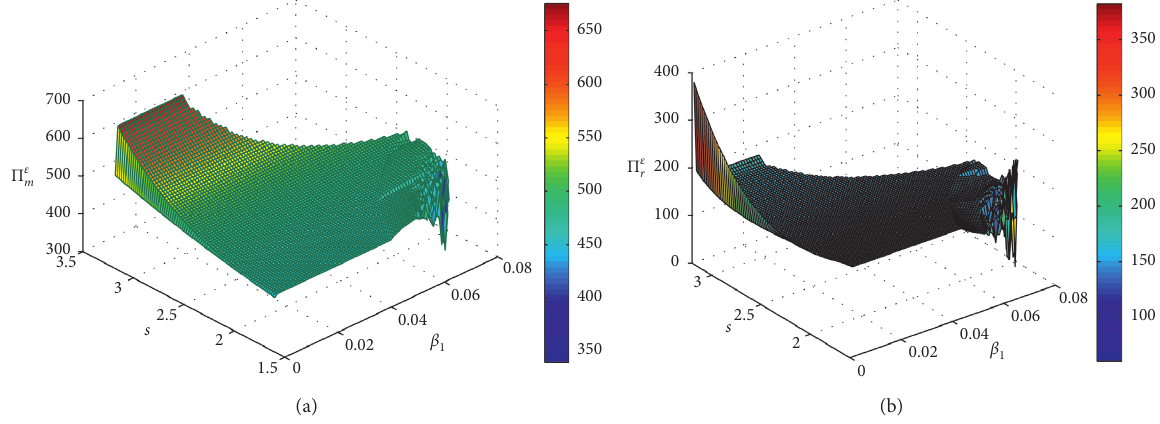
Figure 33: 3D profit diagrams of the manufacturer and retailer with β manufacturer. (b) 3D profit diagrams of the retailer.